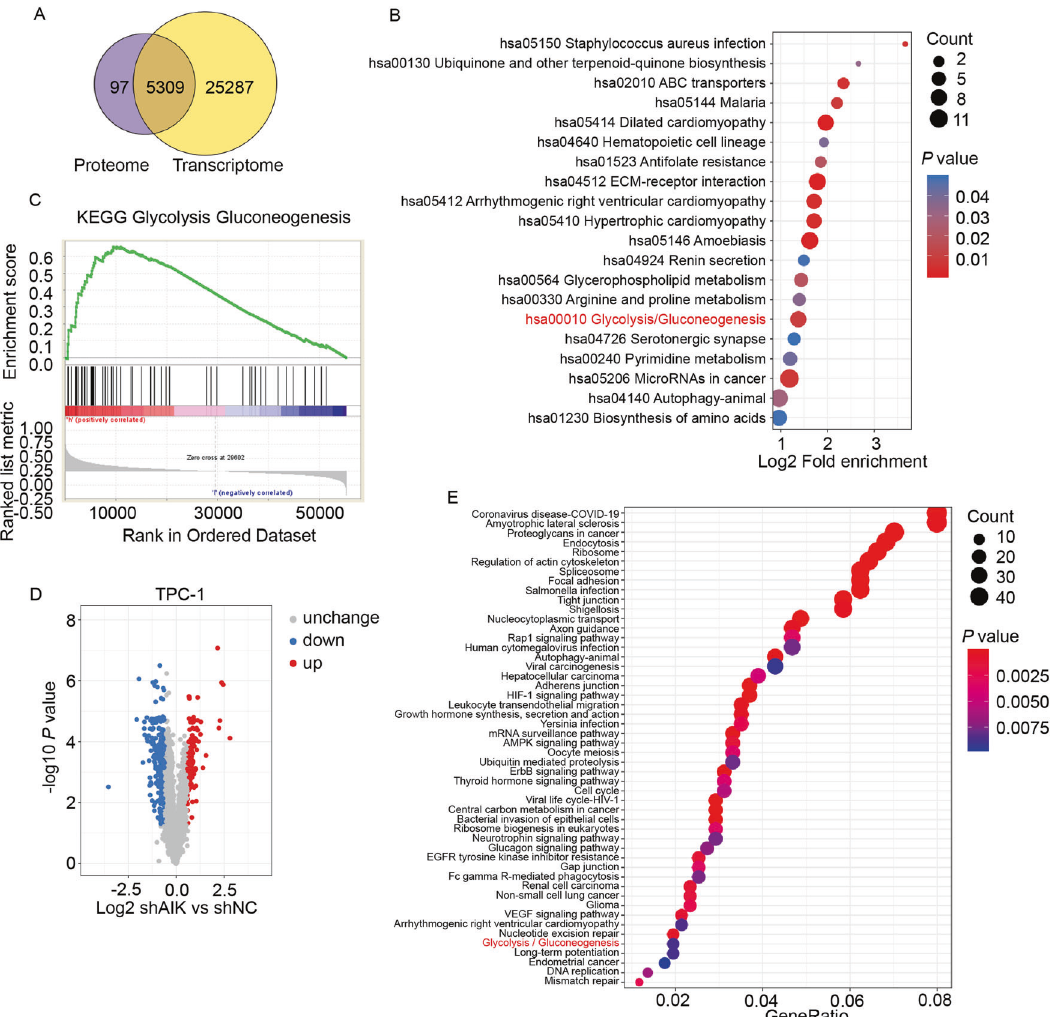
Fig. 3 Multiomics and bioinformatics analyses indicated Aurora-A regulates the glycolysis in TC cells. A The Venn plot of proteome and RNA-seq revealed 5309 genes had signi fi cant alterations at the mRNA and protein levels after Aurora-A knockdown. B KEGG analysis of 5309 genes showed signi fi cant alterations in both proteome and RNA-seq. Glycolysis pathway can be remarkably enriched. C Analysis of TCGA database revealed Aurora-A was positively correlated with the glycolysis pathway. D Volcano plot highlighting phosphorylation changes of proteins. 318 proteins with 423 sites were identi fi ed with greater than 1.5-fold change in Aurora-A knockdown relative to control TPC-1 cells and plotted in red (upregulation) or blue (downregulation), respectively. E KEGG analysis of the phosphorylation-changed proteins after